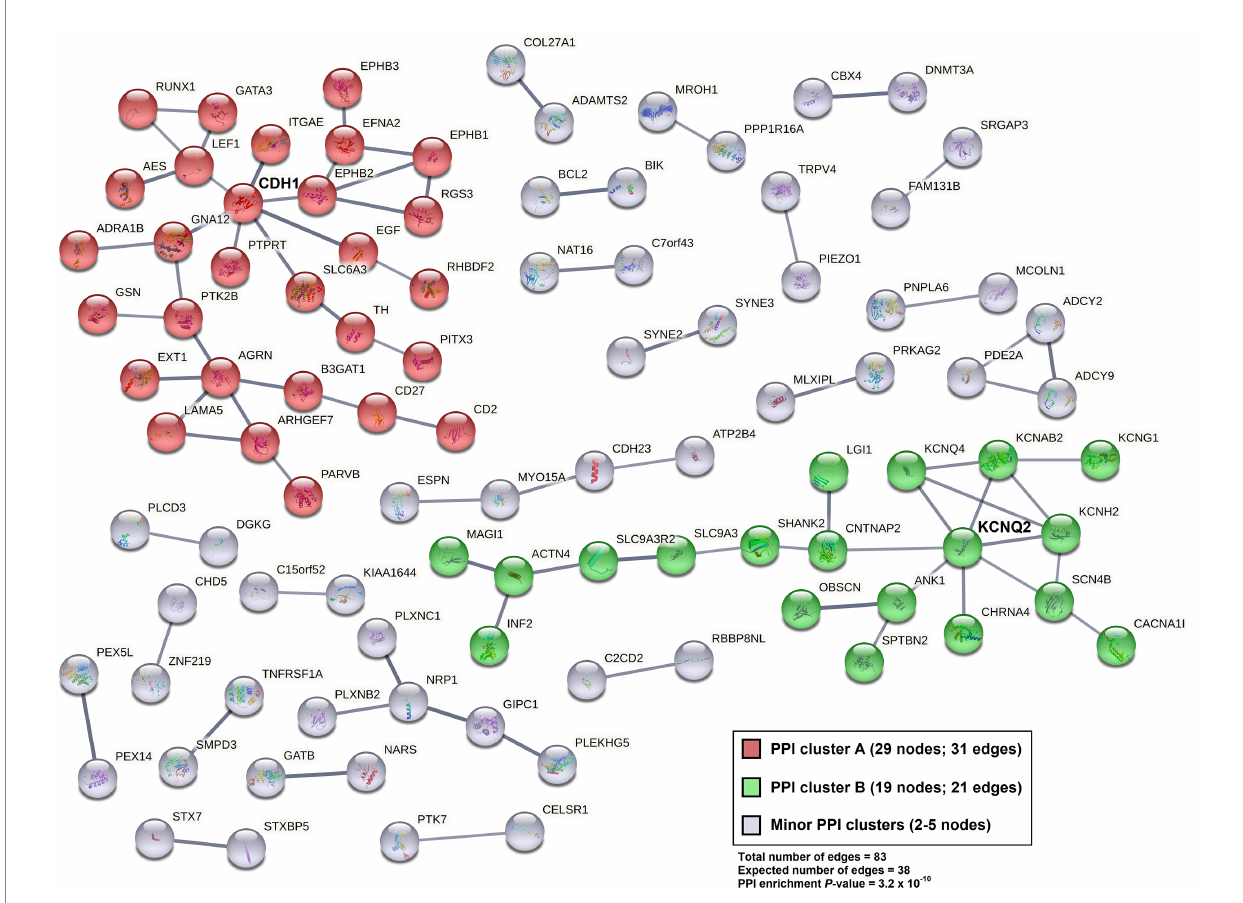
FIGURE 3 Protein–Protein Interaction (PPI) network (STRING v. 11.5; confidence interaction score > 0.7) for genes harboring sites with reduced 5hmC expression levels ( p < 0.05; 3,432 sites localized to 1,627 genes) among NSC cell lines relative to their iPSC pairs.